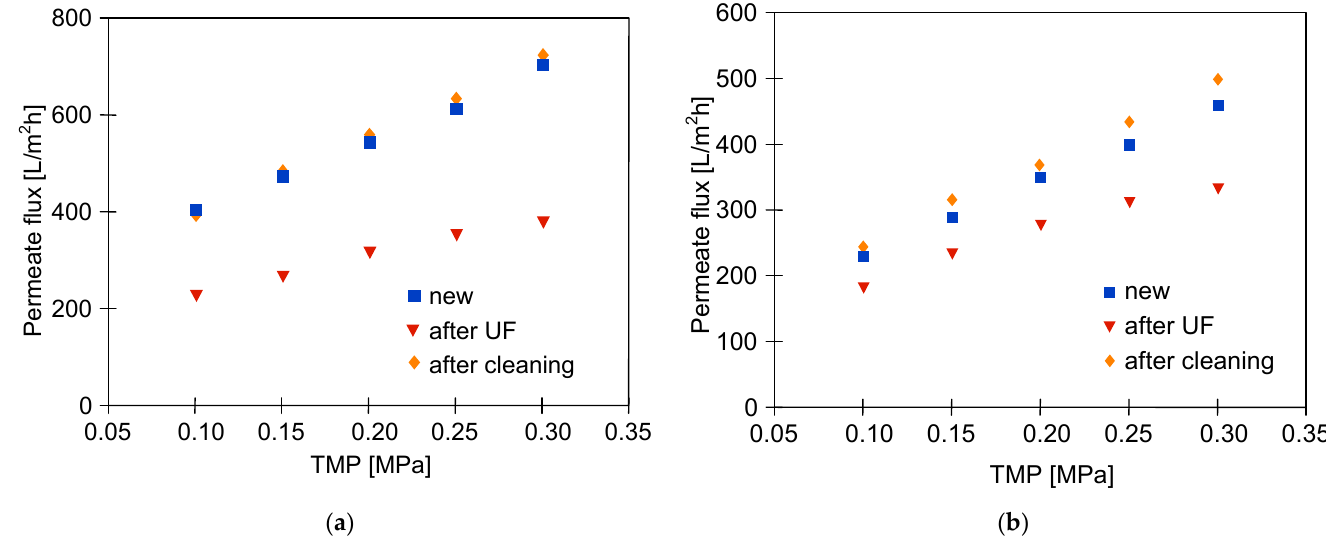
Figure 15. Impact of the TMP on the maximum permeate flux for the membranes after separation of the real wastewaters and after membranes cleaning with NaOH solution (1 g/L) for 2 h. ( a ) UE50, ( b ) UE10.